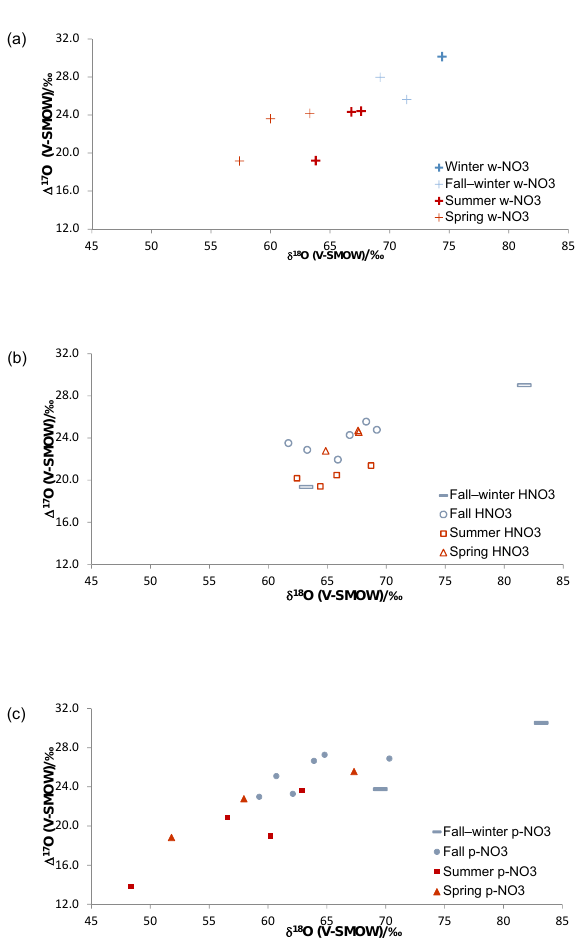
(b) and p NO − (c) , in Al- 3 3